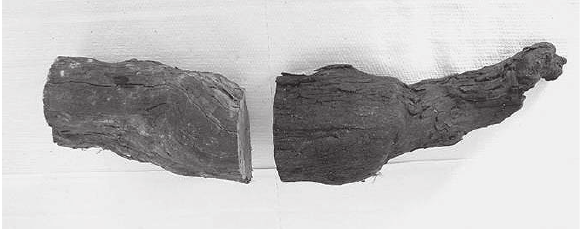
Fig. 3. Wood samples bearing E. lata stromata used in this study (left: not composted; right: after